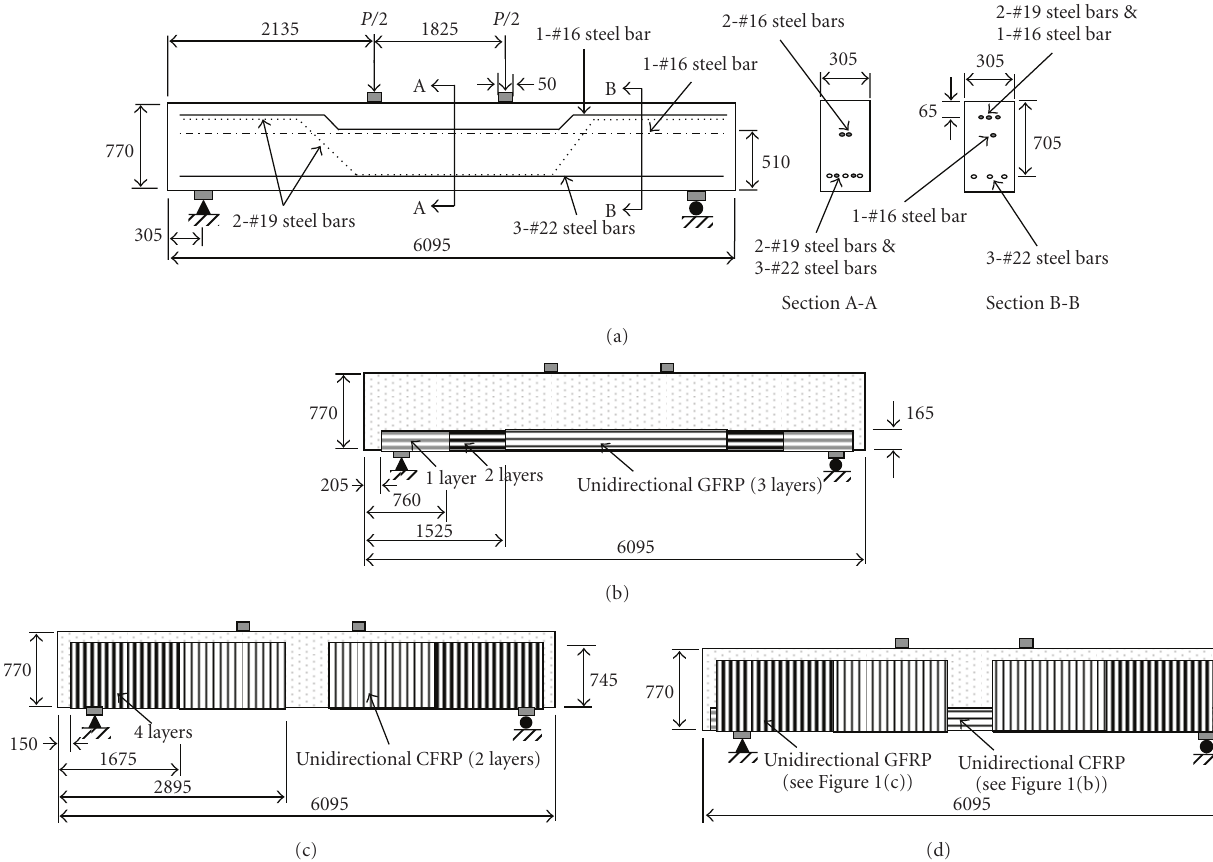
Figure 1: Experimental beams (dimensions shown in mm). (a) Unstrengthened beam; (b) flexural-strengthened beam; (c) shear- strengthened beam; (d) flexural plus shear-Strengthened beam